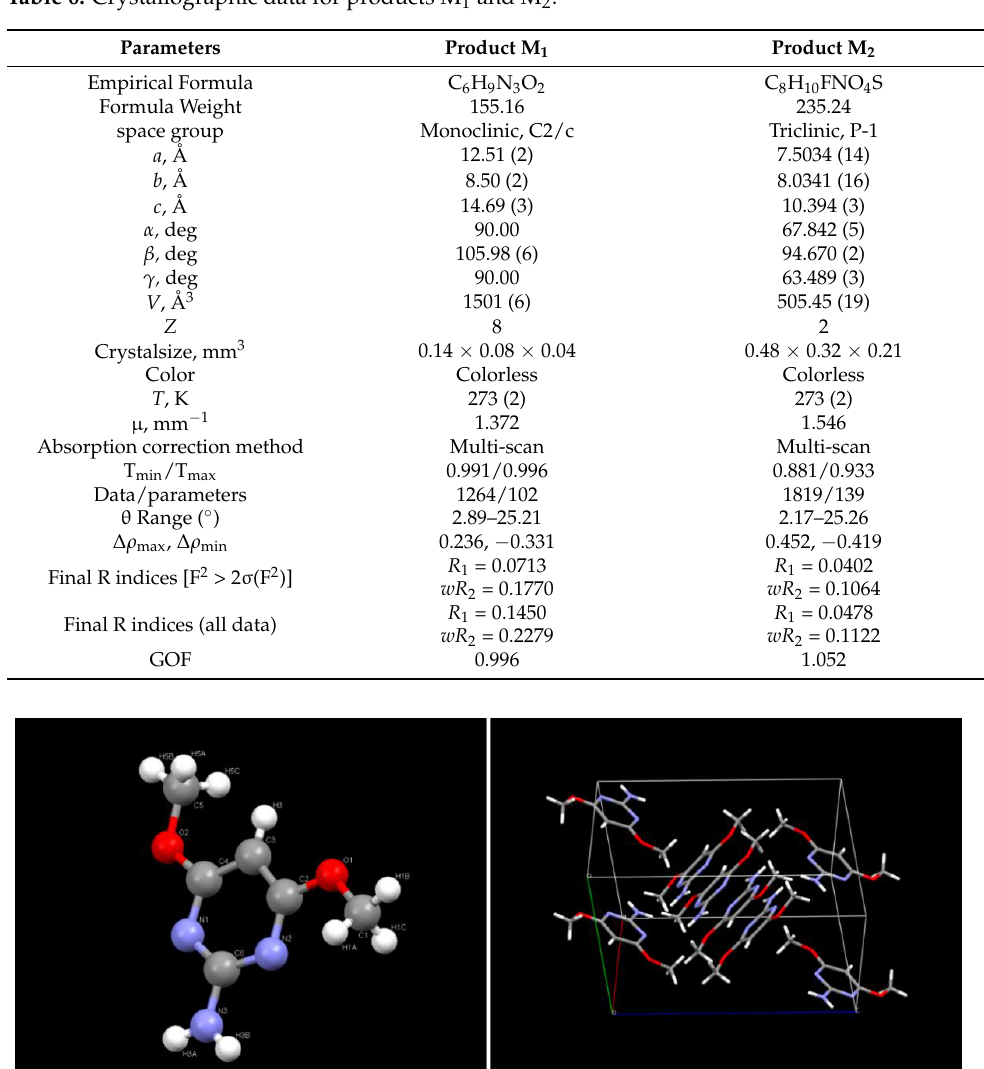
Table 6. Crystallographic data for products M 1 and M 2 .